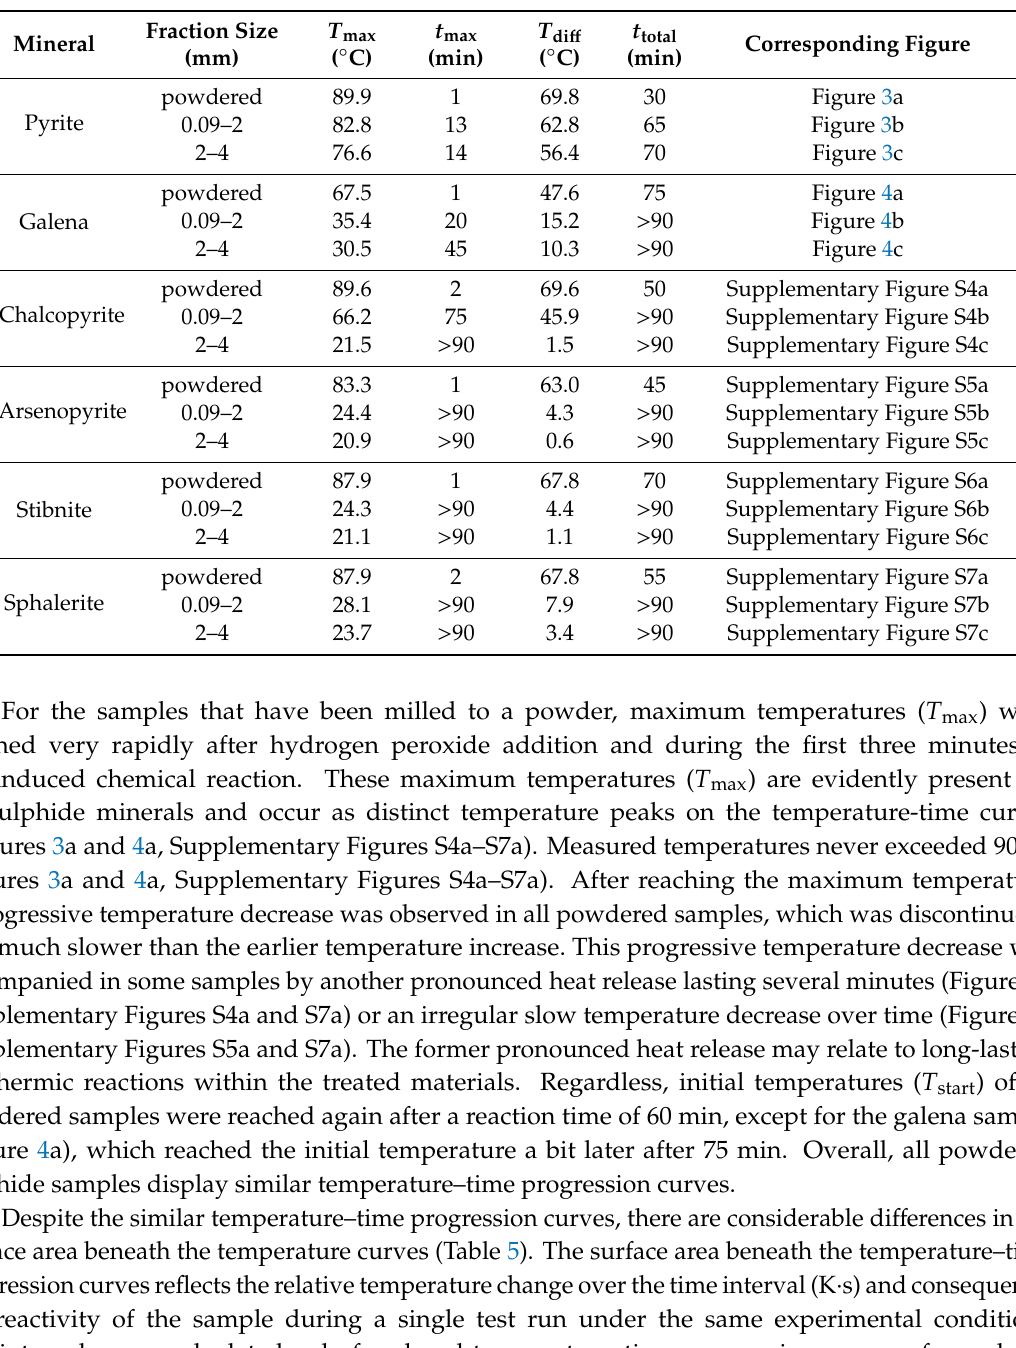
Table 4. List of temperature and time parameters that were recorded for the various size fractions of sulphide minerals during IR thermography testing (maximum temperature, T max ); time to reach the maximum temperature, t max ; calculated temperature di ff erence, T di ff ; total reaction time, t total ). Reactions that lasted longer than 90 min were terminated after this time ( >